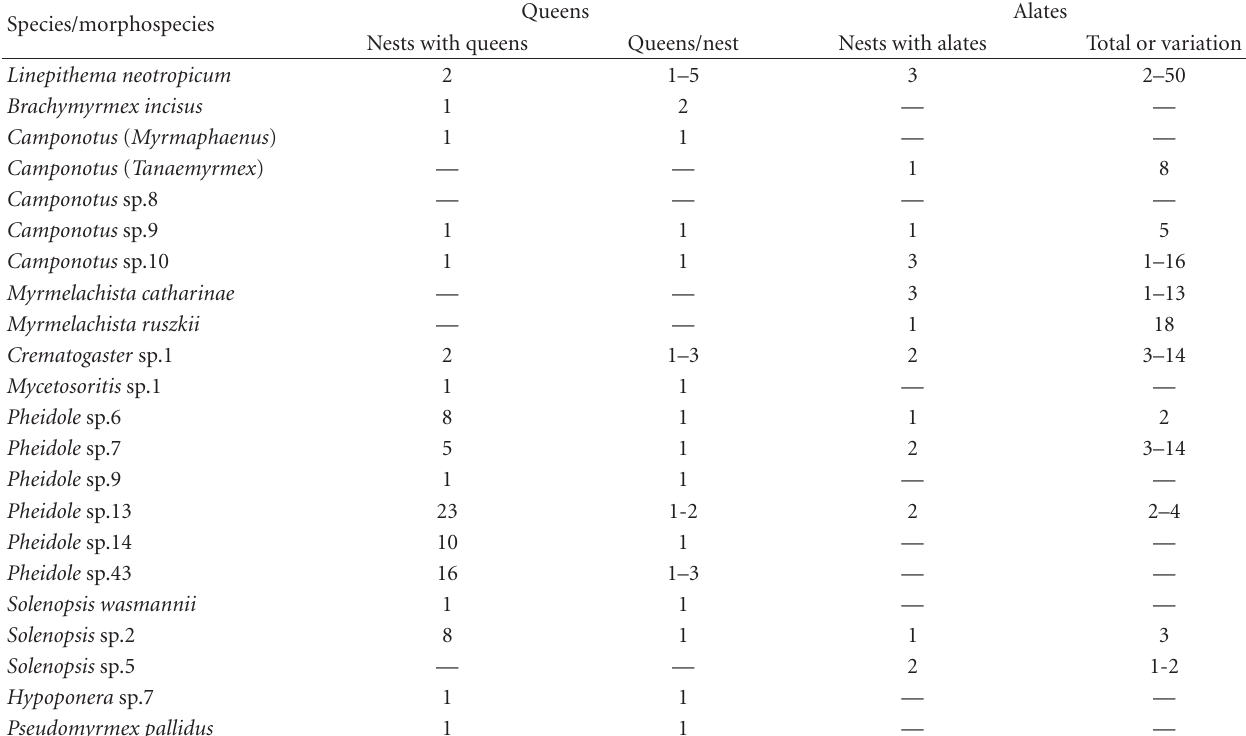
Table 3: Presence of queens and alates among the species reported in undecomposed twigs in the leaf litter of dense ombrophilous forests. Queens Species/morphospecies Nests with